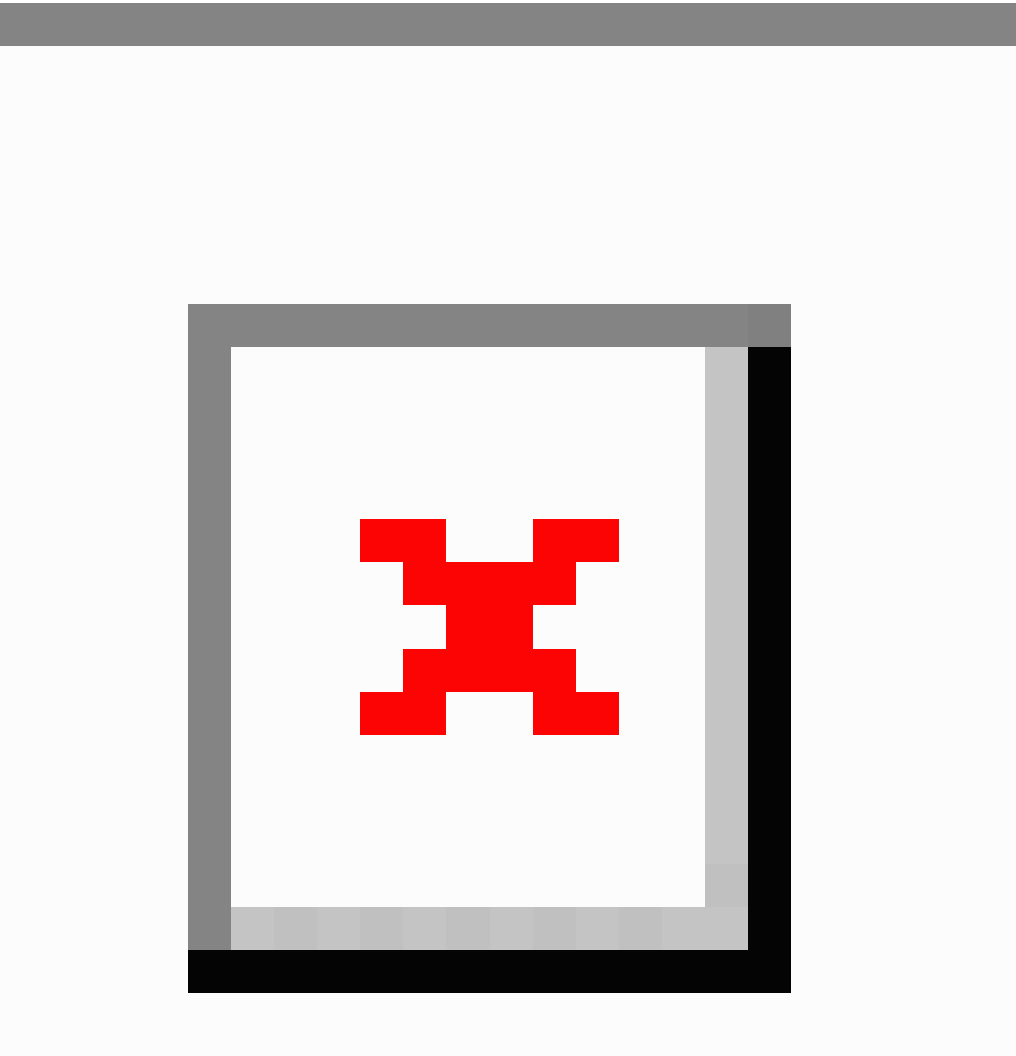
Figure 10. Forest plot of blended learning to traditional learning comparison for knowledge outcomes for nurses as students. df: degree of freedom; CI: confidence